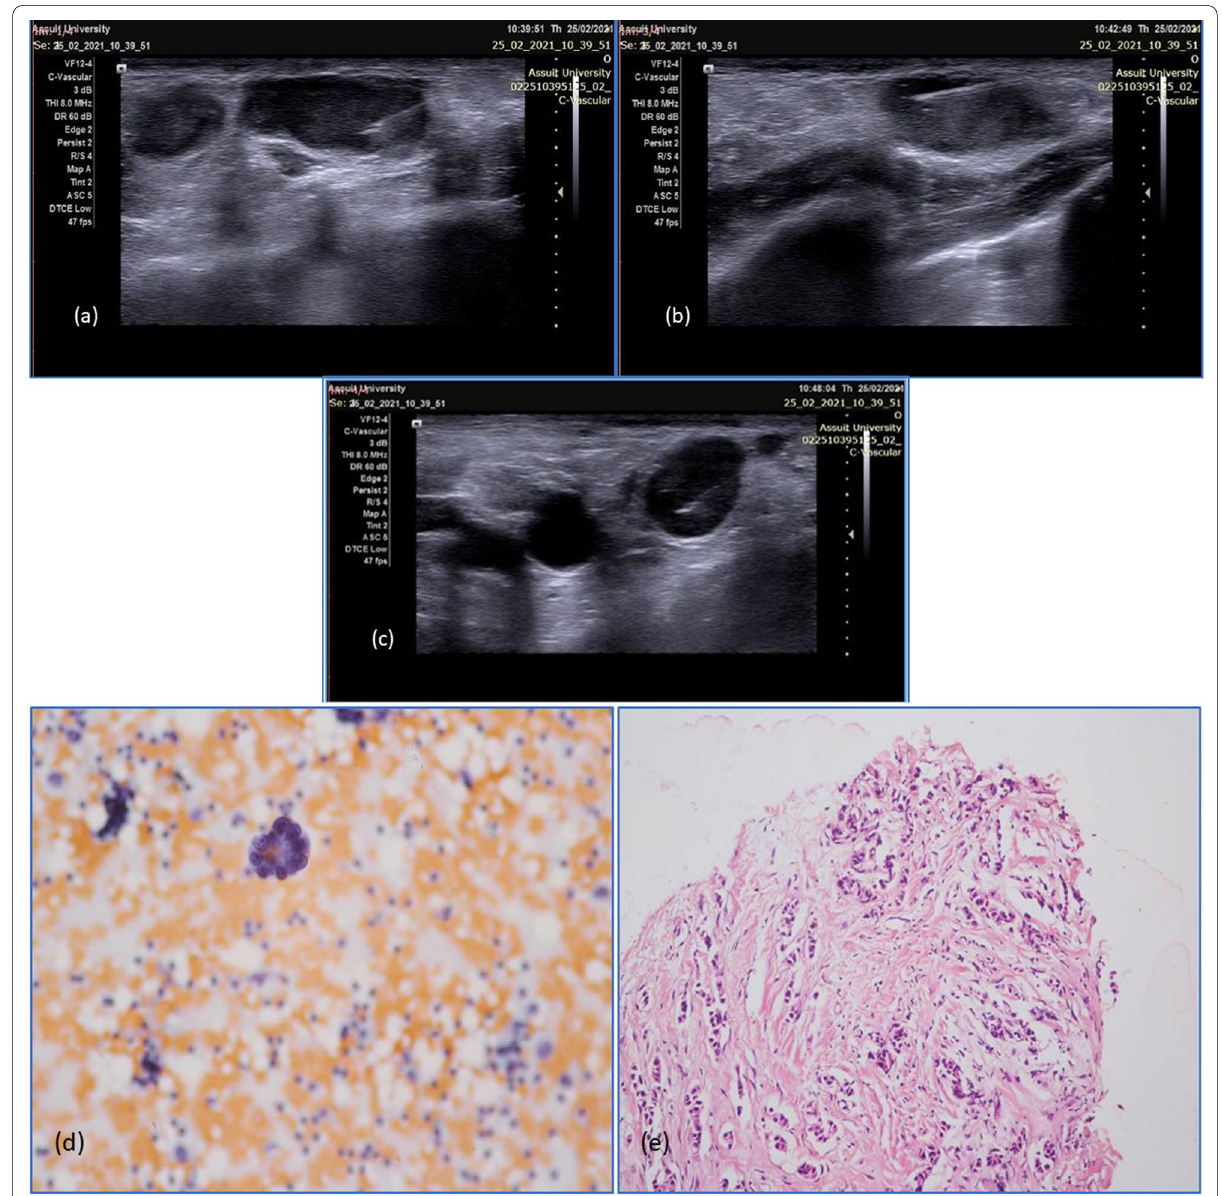
Fig. 5 An 43‑year‑old female patient presented with breast cancer, FNAC and CNB were obtained simultaneously from the largest and most suspicious node and another FNAC aspirate was obtained from another suspicious lymph node. The final histopathological evaluation showed metastatic lymph nodes harboring malignancy. a , b axillary ultrasound showed multiple suspicious lymph nodes, the largest was oval in shape and measures about 23 8 mm, with loss of its hilum, FNAC and CNB were obtained from this node. c another smaller round node was seen × measuring about 15 10 mm, in which FNAC was also taken from this node, all obtained biopsies were containing malignant metastatic cells. d × Photomicrograph of a lymph node cytology smear: a single acinus of malignant ductal carcinoma on the lymphoid background (Papanicolaou stain, 400X). e Photomicrograph of tissue section of metastatic ductal carcinoma in the lymph node. Many nests and cords of neoplastic cells are separated by desmoplastic stroma (Hematoxylin and Eosin stain,